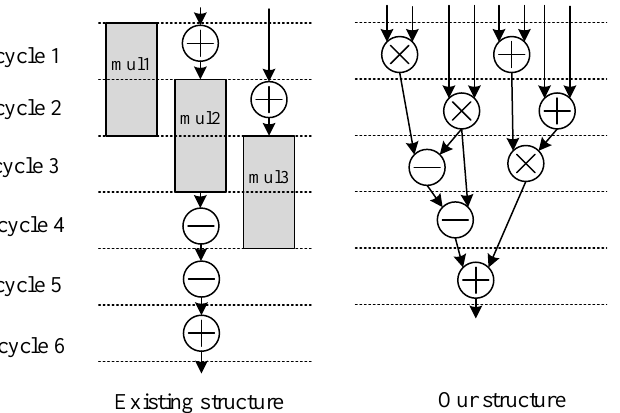
Figure 1. Multiplication operational schedule between existing structure and our structure.